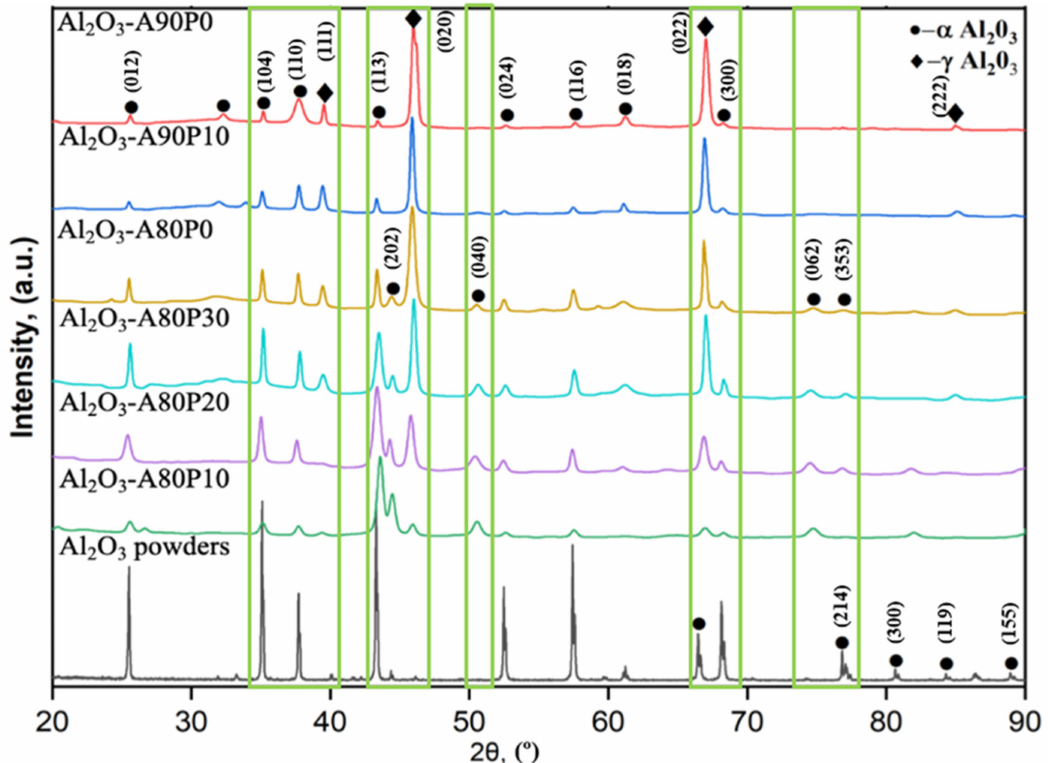
Figure 3. Diffraction patterns of Al 2 O 3 coatings obtained under different modes of detonation spraying.